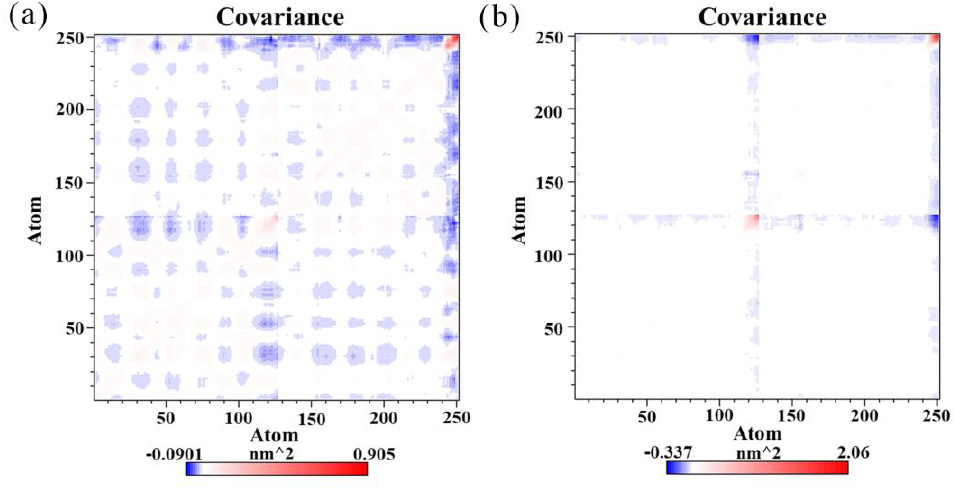
Figure 6. Cross-correlation matrixes of fluctuations in the x -, y -, and z -coordinates for Cα atoms belonging to the PD-L1 dimer in the ( a ) dimer system and ( b ) S system.